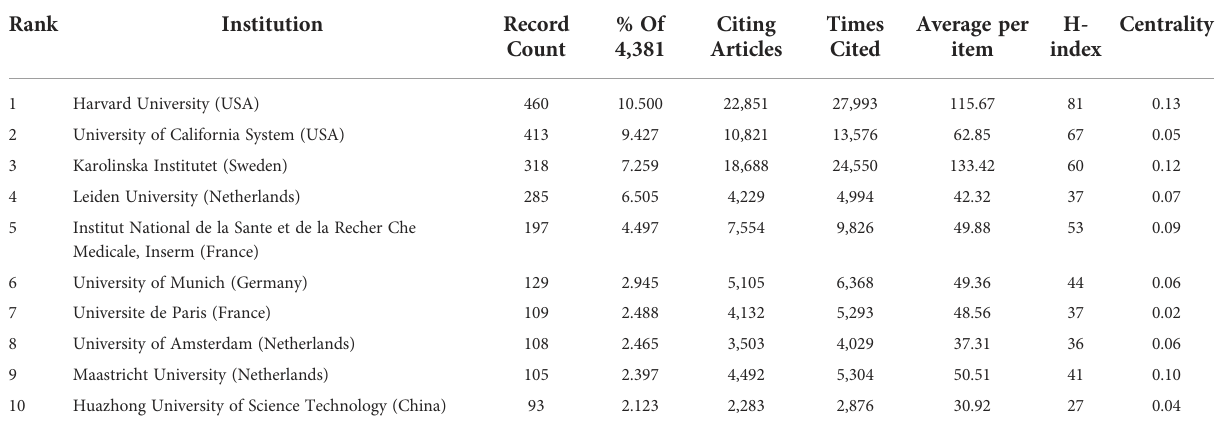
TABLE 4 Top 10 institutions in T cell and AS. Rank Institution Record